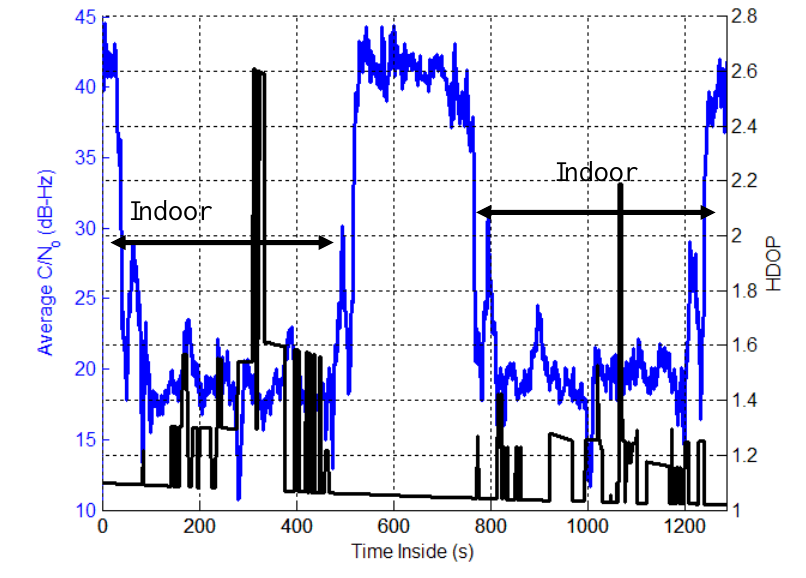
and HDOP (Olympic Oval Data o